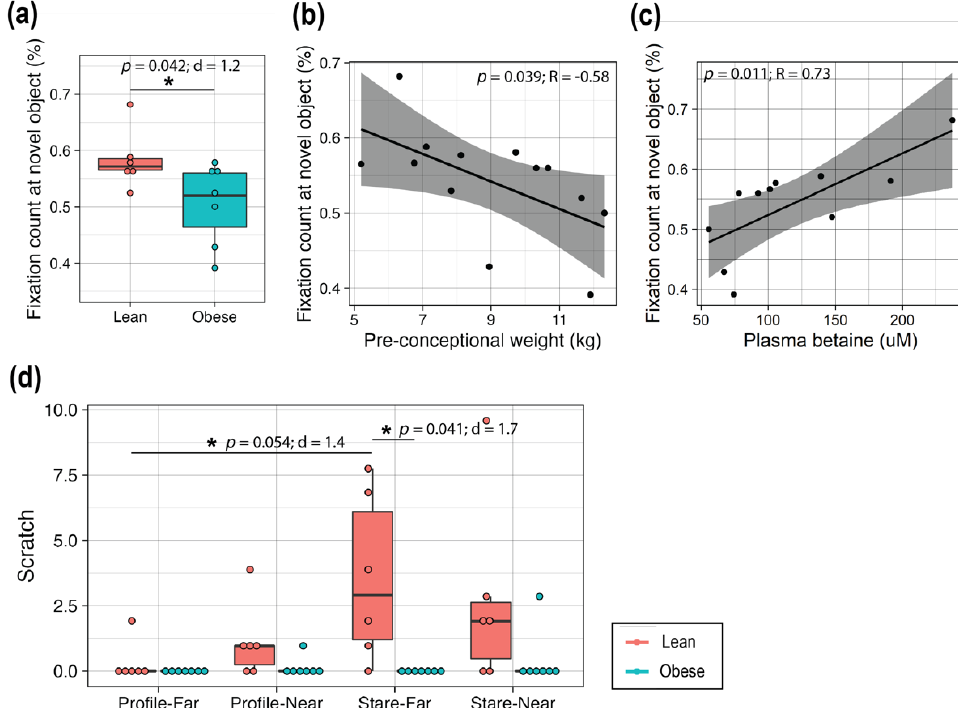
Figure 7. Assessment of brain function in offspring. ( a ) Proportional fixation count (%) at the novel object in the VPC test that was applied to infants at PD30. ( b ) Correlation between the pre-conceptional weight and the proportional fixation count at a novel object. ( c ) Correlation between the maternal plasma betaine level at GD90 and the proportional fixation count at a novel object. In ( b , c ), the black line represents the Pearson correlation regression line, and the gray area represents the 95% confidence interval. ( d ) Results of the HI test at PD110. Profile-Far (a technician presented the profile face from ~1 m away from the infant in a cage); Profile-Near (profile face presented from 0.3 m away); Stare-Far (a technician stared into the eyes of the infant from ~1 m away); Stare-Near (stared from 0.3 m away). t -tests were used to test for group differences in ( a , c ). For box plots ( a , d ), each dot represents data from an individual animal. Top and bottom of the boxes represent the 25th and 75th percentiles respectively; the middle line represents the median; and the top and bottom whiskers represent maximum and minimum values. Points outside of the whiskers represent outliers. Statistical significance is indicated with “*”. The data are expressed as the mean ± SE, and the red and blue bars correspond to the Lean and Obese groups, respectively. Sample size: Lean = 6, Obese = 7. Abbreviations: Eff, effect size; d or R, effect size measurements; VPC, Visual Paired-Comparison;